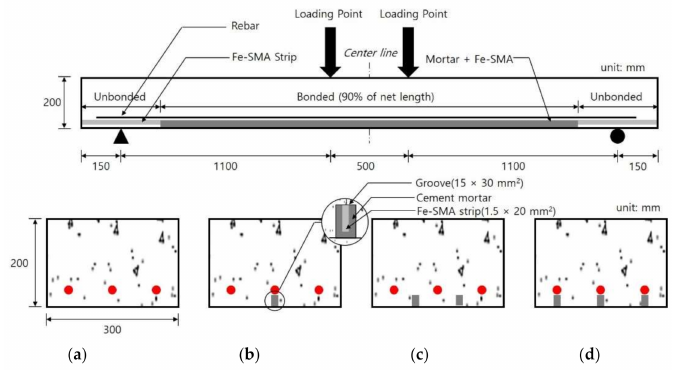
Figure 1. Details of experimental specimen: ( a ) SL-CTRL; ( b ) SL-30S-4; ( c ) SL-60S-4; ( d ) SL-90S-4 [18].